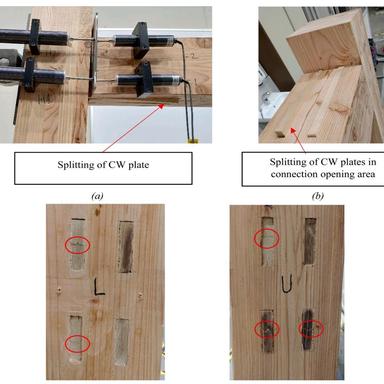
Typical failure mechanism in the connection area of the glued frame (a) splitting of CW plates at loaded side, (b) splitting of CW plates at unloaded side, (c) CW plates failure along the row of dowels at loaded end, (d) CW plates failure along the row of dowels at unloaded end.